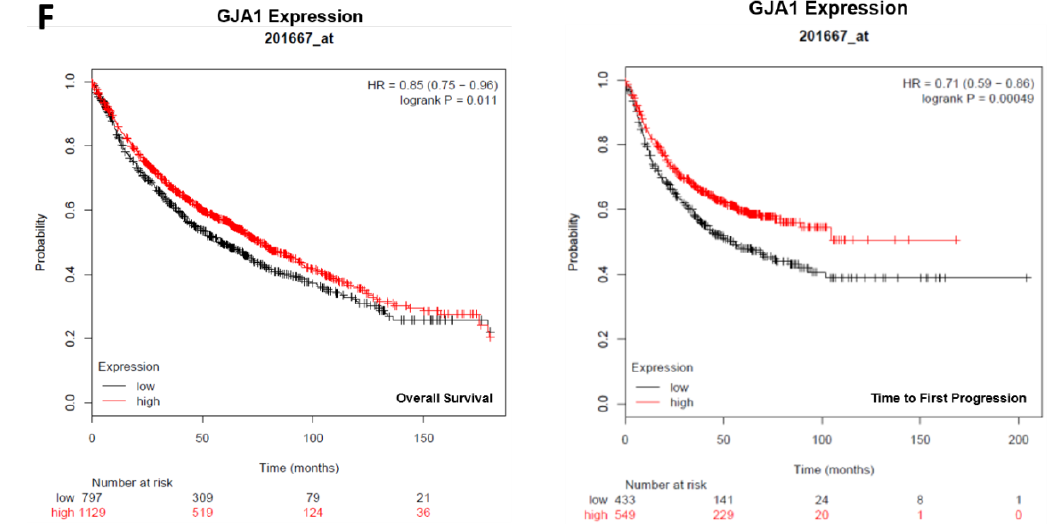
Figure 2. Cx43 in cancer. ( A – D ) Cx43 expression in NSCLC and ovarian cancer cells: RNA ( A , C ) and protein ( B , D ). ( A , C ) Total RNA was extracted from cells and analyzed using StaRT-PCR, as described in Section 4. Each PCR was run in triplicate. The transcript levels are represented as Cx43 mRNA/10 6 ACTB mRNA. The values are represented as mean ± SEM from triplicate PCRs. ( B , D ) Whole cell lysate from the cells were probed with antibody for Cx43 with α -tubulin as a loading control. ( E ) Graph indicates the frequency of GJA1 somatic mutations in different cancers extracted from cancer studies in the TCGA (The Cancer Genome Atlas) (data retrieval date November 23rd 2016). Cancer abbreviations are BRCA, breast invasive carcinoma; ccRCC, clear cell Renal Cell Carcinoma; CESC, cervical squamous cell carcinoma; COAD, colorectal adenocarcinoma; LIHC, liver hepatocellular carcinoma; LUAD, Lung Adenocarcinoma; LSC, Lung Squamous Carcinoma; SKMC, cutaneous melanoma; STAD, stomach adenocarcinoma; UC, uterine carcinoma. The graph has been divided to indicate mutation frequencies in hypermutated and non-hypermutated cancer. ( F ) Survival plots indicating probability of overall survival and time to first progression in lung cancers based upon GJA1 expression in human tumors obtained from kmplotter.org.